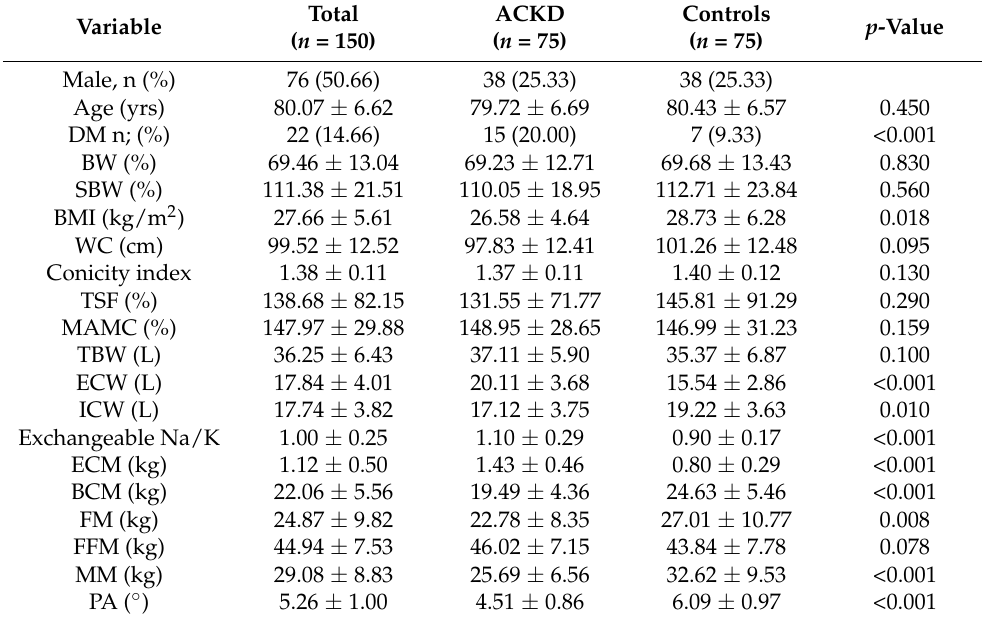
Table 1. Demographic, clinical, and body composition parameters of the 150 participants in the study. Variable